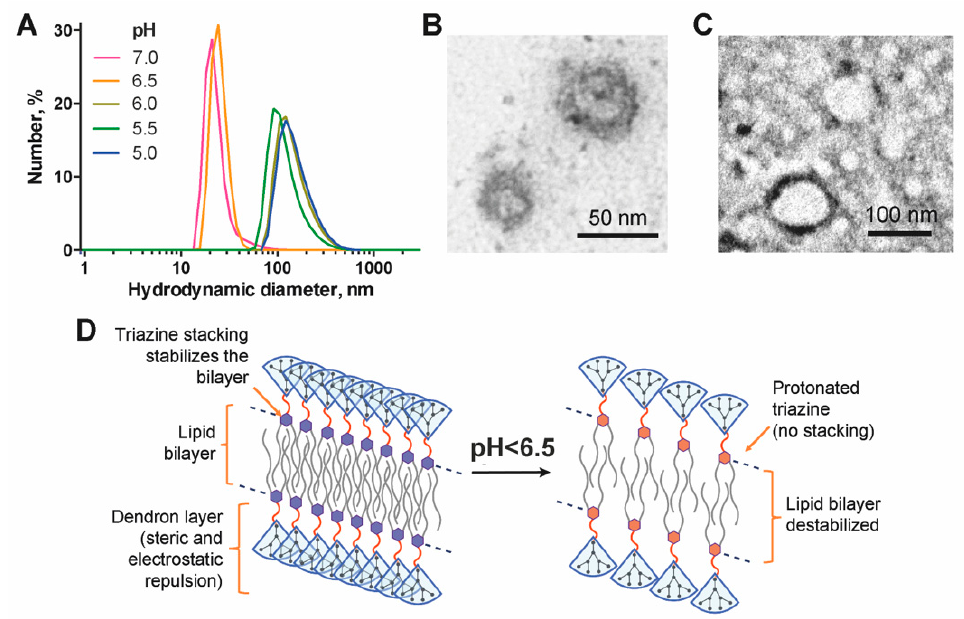
Figure 3. Self-assembly of dendritic amphiphiles. DLS profiles for supramolecular associates of dendron (100 µM) exposed to different pH in 10 mM Na-phosphate buffer (A) ; representative TEM images of dendrons’ supramolecular associates at pH 7.0 (B) and pH 5.0 (C) ; tentative scheme of the pH-dependent behaviour of a dendron bilayer (D) .